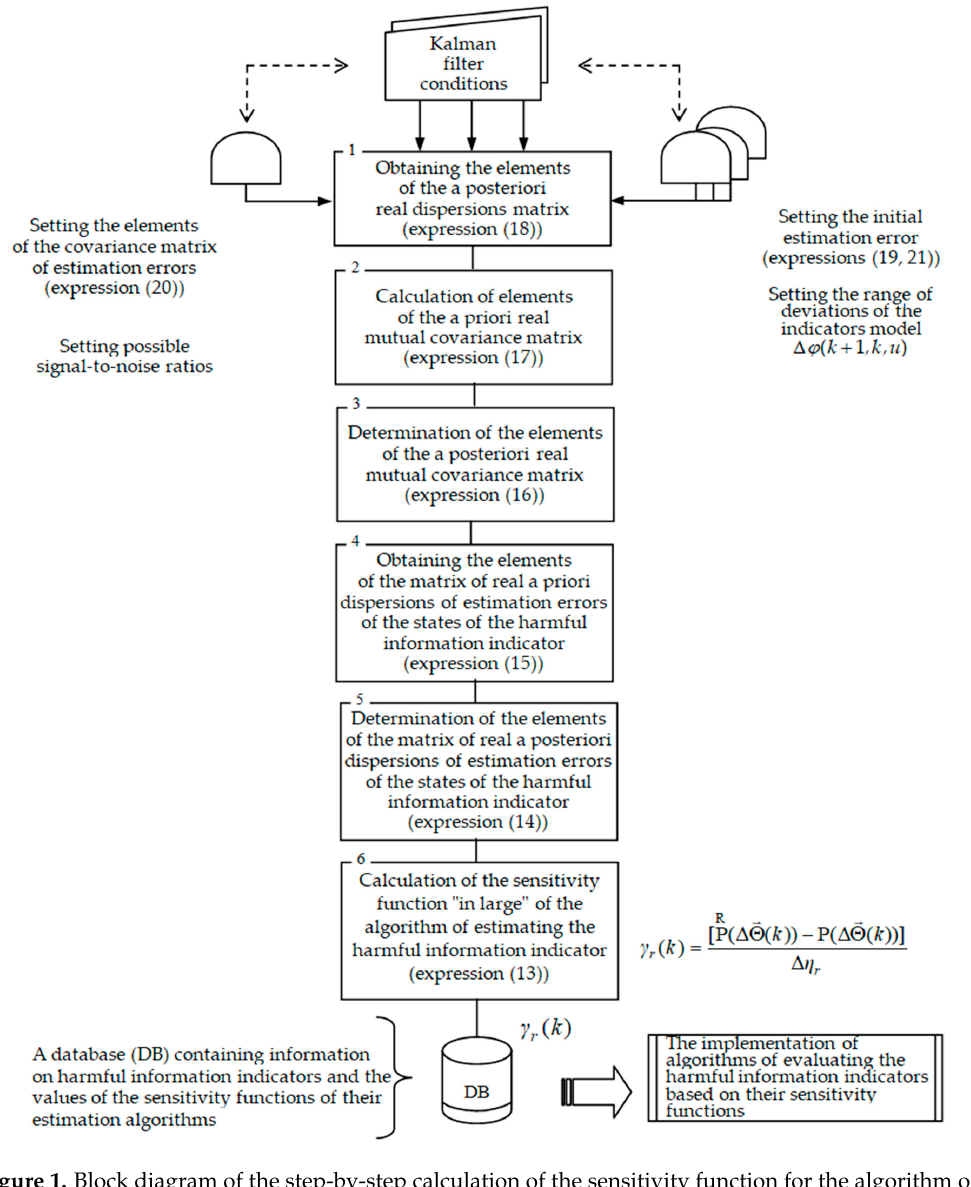
Figure 1. Block diagram of the step-by-step calculation of the sensitivity function for the algorithm of evaluating of harmful information indicators.